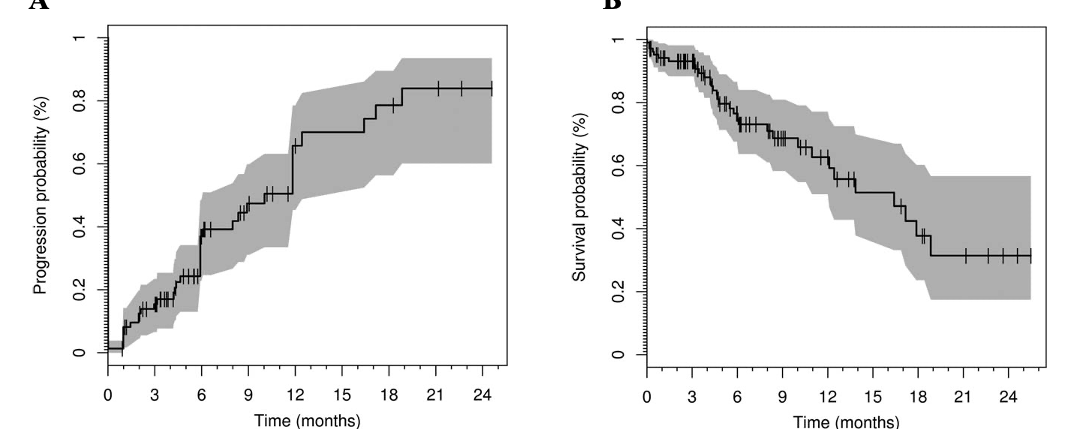
Figure 2. Radioembolization with yttrium-90 glass microspheres in hepatocellular carcinoma. ( A ) TTP (with progression defined according to RECIST with the recent NCI amendments) in 76 of 108 HCC patients treated by Y-90 glass microsphere radioembolization for which radiological response data were available. The solid line displays the Kaplan – Meier estimator, with marks representing